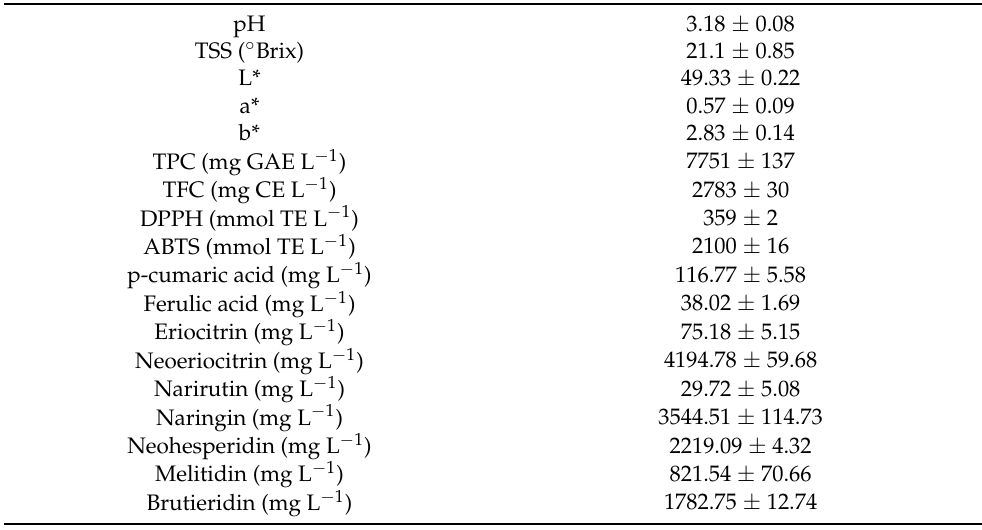
Table 2. Physicochemical characterization of antioxidant extract from bergamot pomace